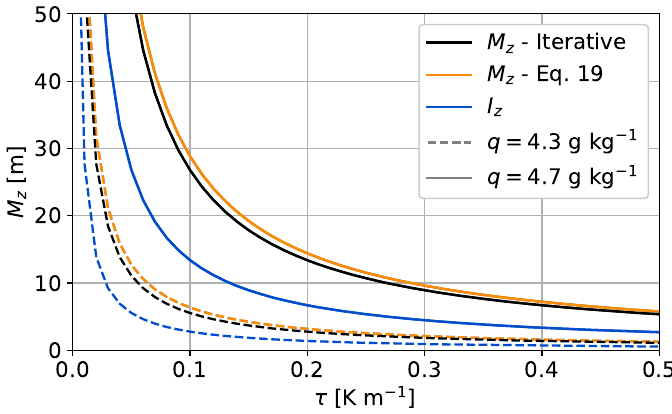
Figure 4. M z and I z as a function of slope for a linear temperature profile with T 0 = 275 K and two values of q , corresponding to relative humidities at the surface of 102% and 110%, respectively. M z is determined iteratively as well as using the approximate solution in Equation (19). Note that in both cases, M z ∼ 2 I z